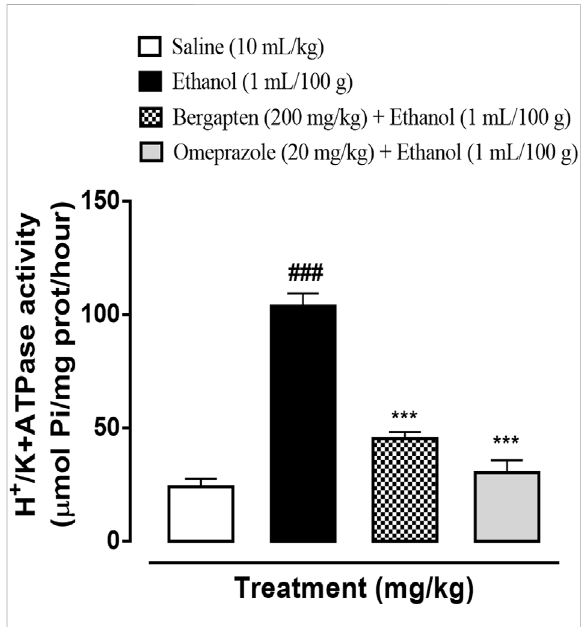
FIGURE 7 Effectofbergaptenandomeprazoleondecreasing ratgastric H + /K + ATPase activity in the ethanol-induced gastric ulcer model. The data values are expressed as mean ± SEM ( n = 3). One-way analysis of variance with post hoc Tukey ’ s test. ### p < 0.001 vs. saline group, *** p < 0.001 vs. ethanol